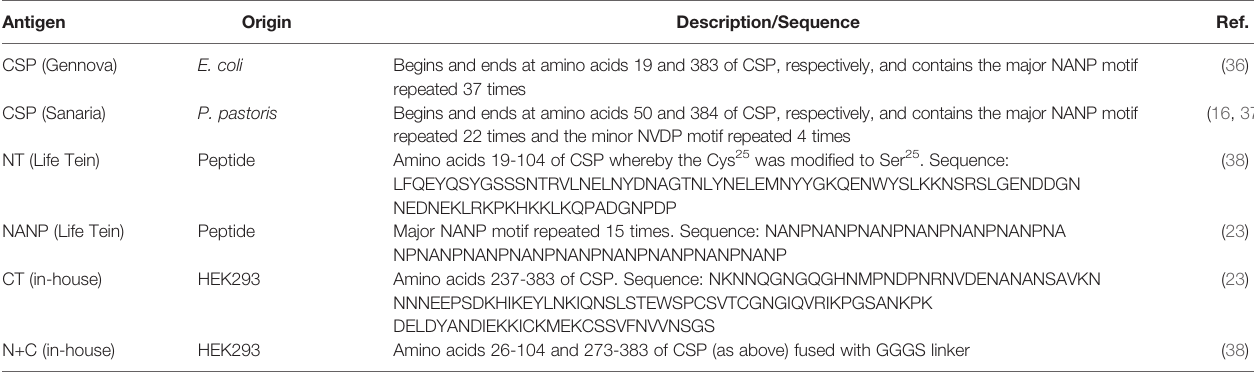
TABLE 1 | Summary of P. falciparum antigens used in the study based on the 3D7 strain.